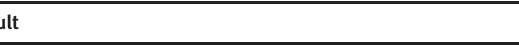
Figure 5: Variation of dielectric constant of the CuCl residue as a function of temperature.